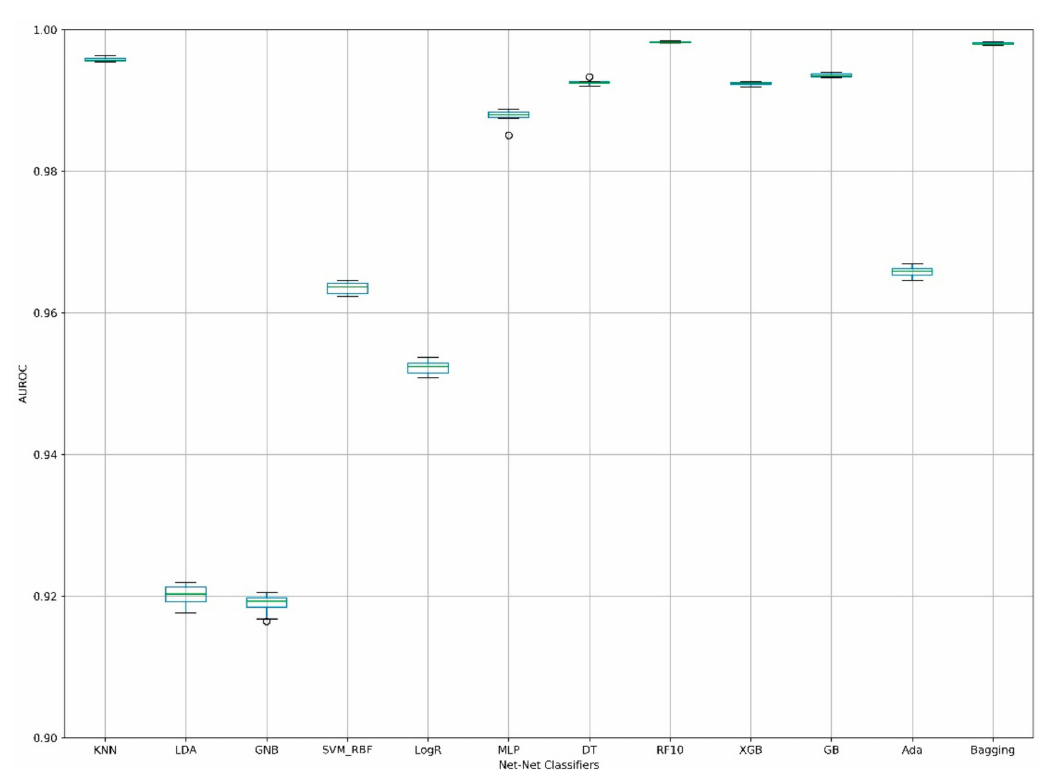
Figure 2. Box plot for the AUROC values of 12 Net-Net AutoML classification